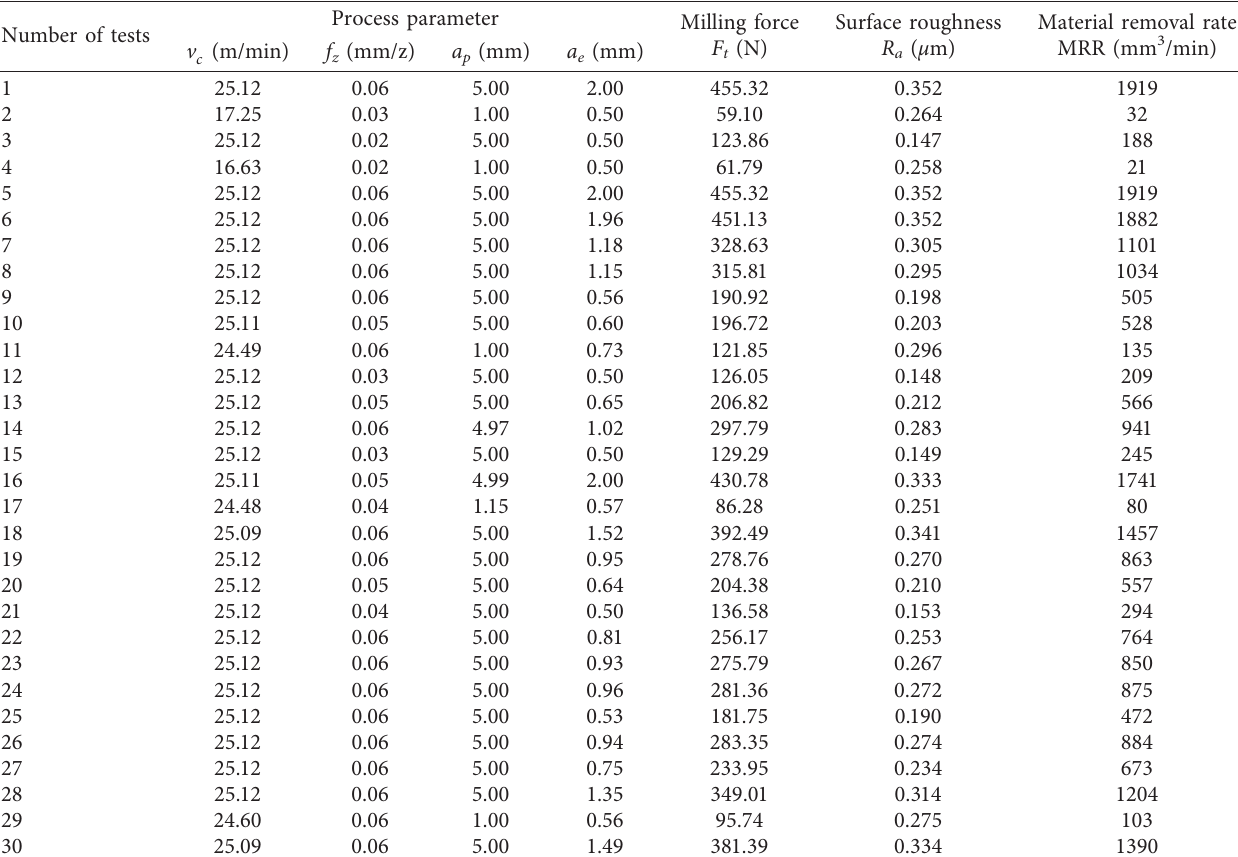
Table 7: Results of NSGA-II (only first 30 solutions were taken).